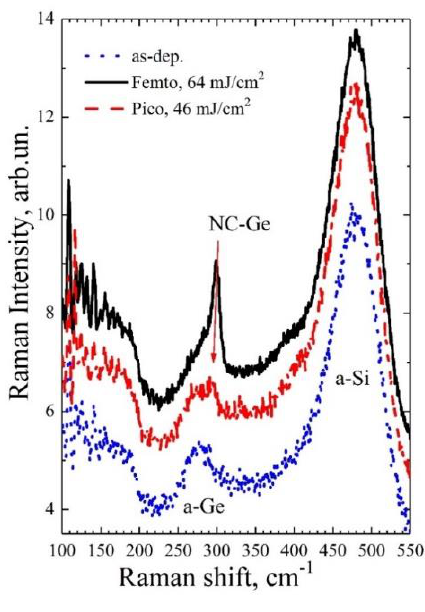
Fig. 1. Raman spectra of as-deposited and low-fluence laser annealed Si/Ge ML stack. The arrow shows a small peak of Ge nanocrystals produced by ps laser